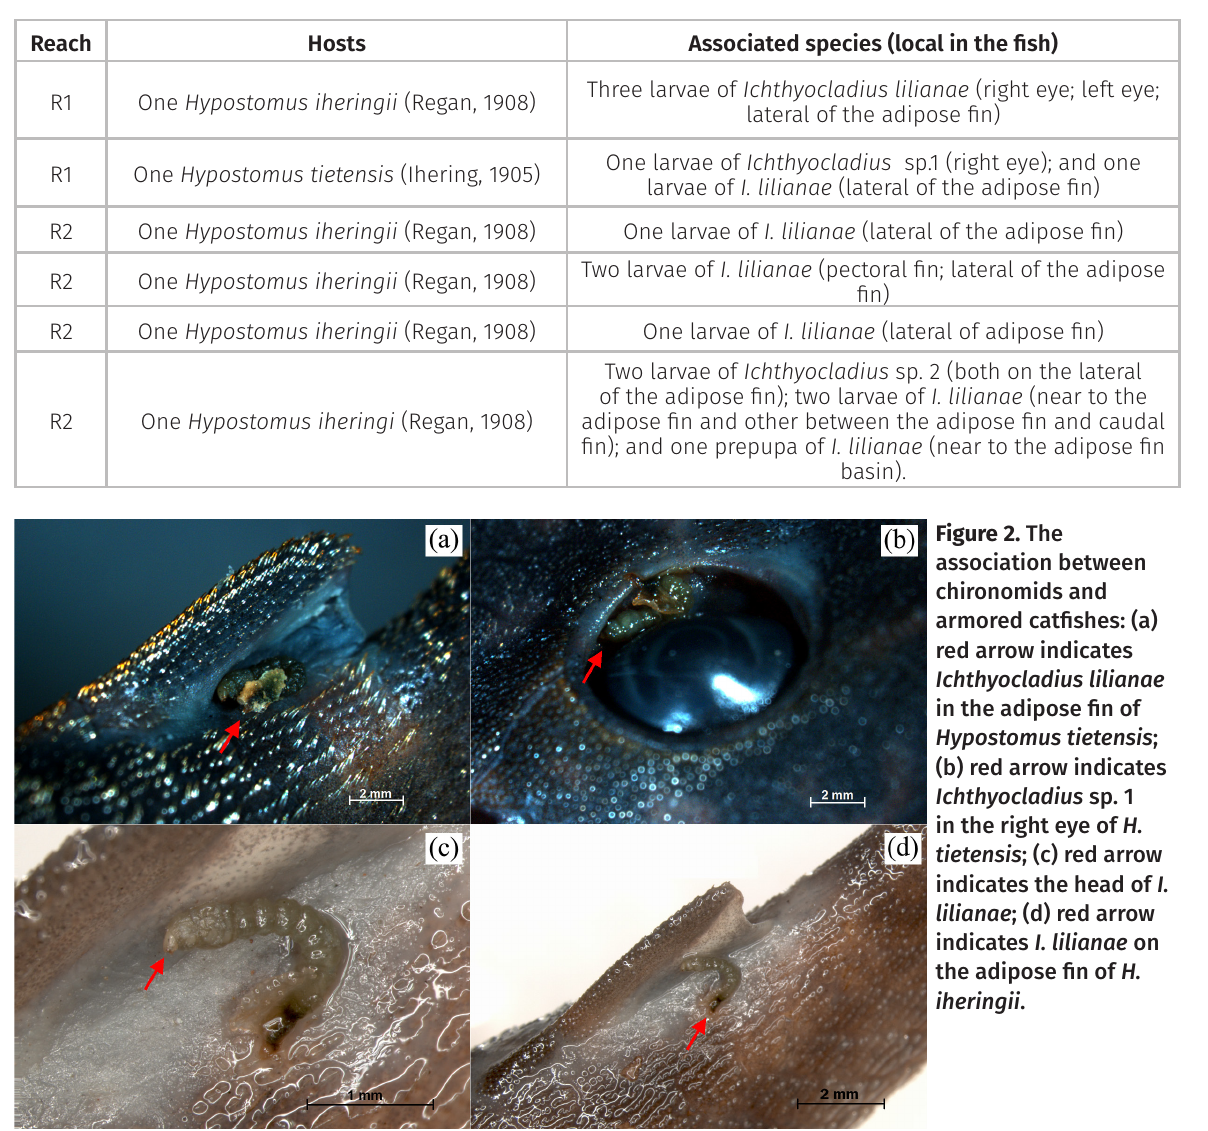
Table I. Chironomids associated with armored catfishes from the Guareí River basin, São Paulo, Brazil. Classifications and voucher numbers can be found in Table SI.